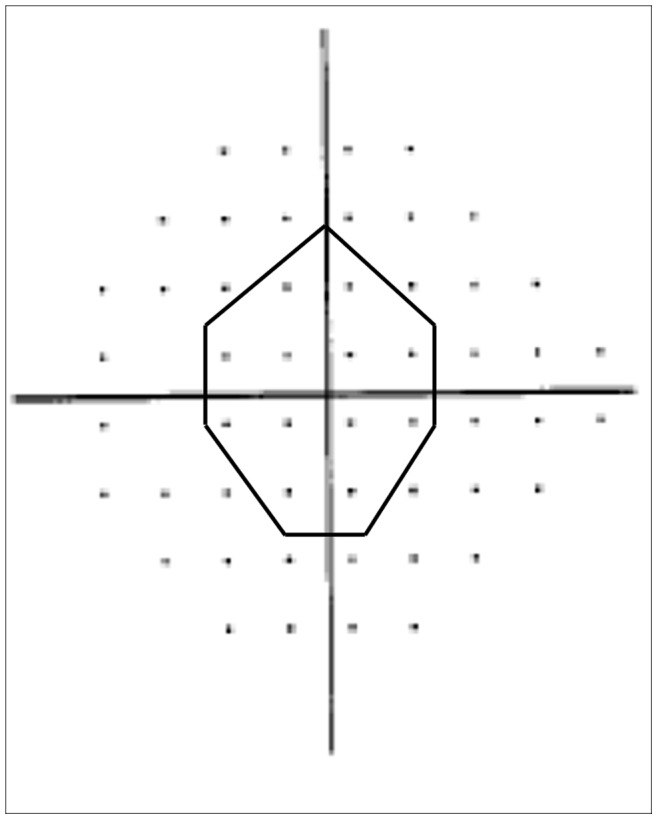
Pattern deviation plot to identify parafoveal scotoma defined by abnormal points within 12 points (shown by the dashed-line).The visual field defect would include those within 10° of fixation with at least one point at p<1% lying at the two innermost paracentral points.